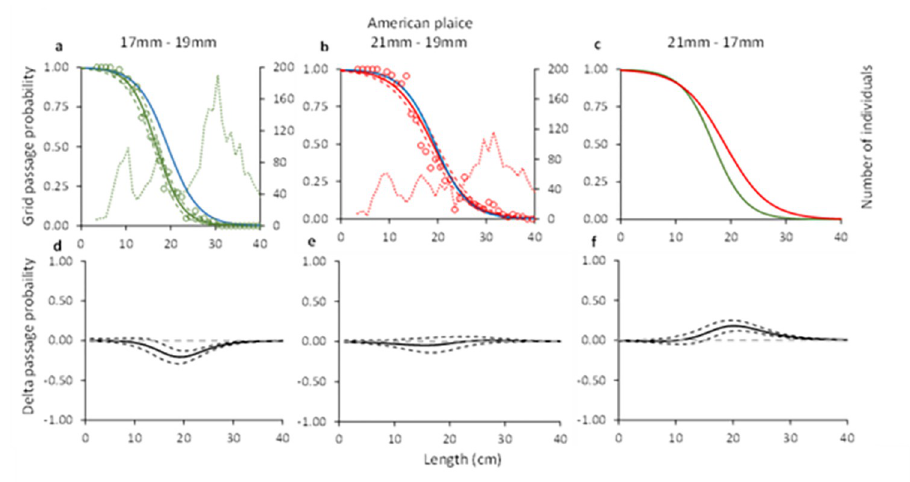
Fig 4. Grid passage probability for American plaice (a-c). Circles illustrate experimental rates, solid curves represent the fitted model, and the stippled curves are the 95% CI’s. Green lines and circles represent the data for grid with 17 mm bar spacing, red– 21 mm grid spacing, and blue line–grid with 19 mm grid spacing. Dotted green and red lines represent total population size structure retained by the gear. Plots d-f show the difference in the length-dependent grid passage probability (delta) between the different grids with 95% CI’s (stippled lines).